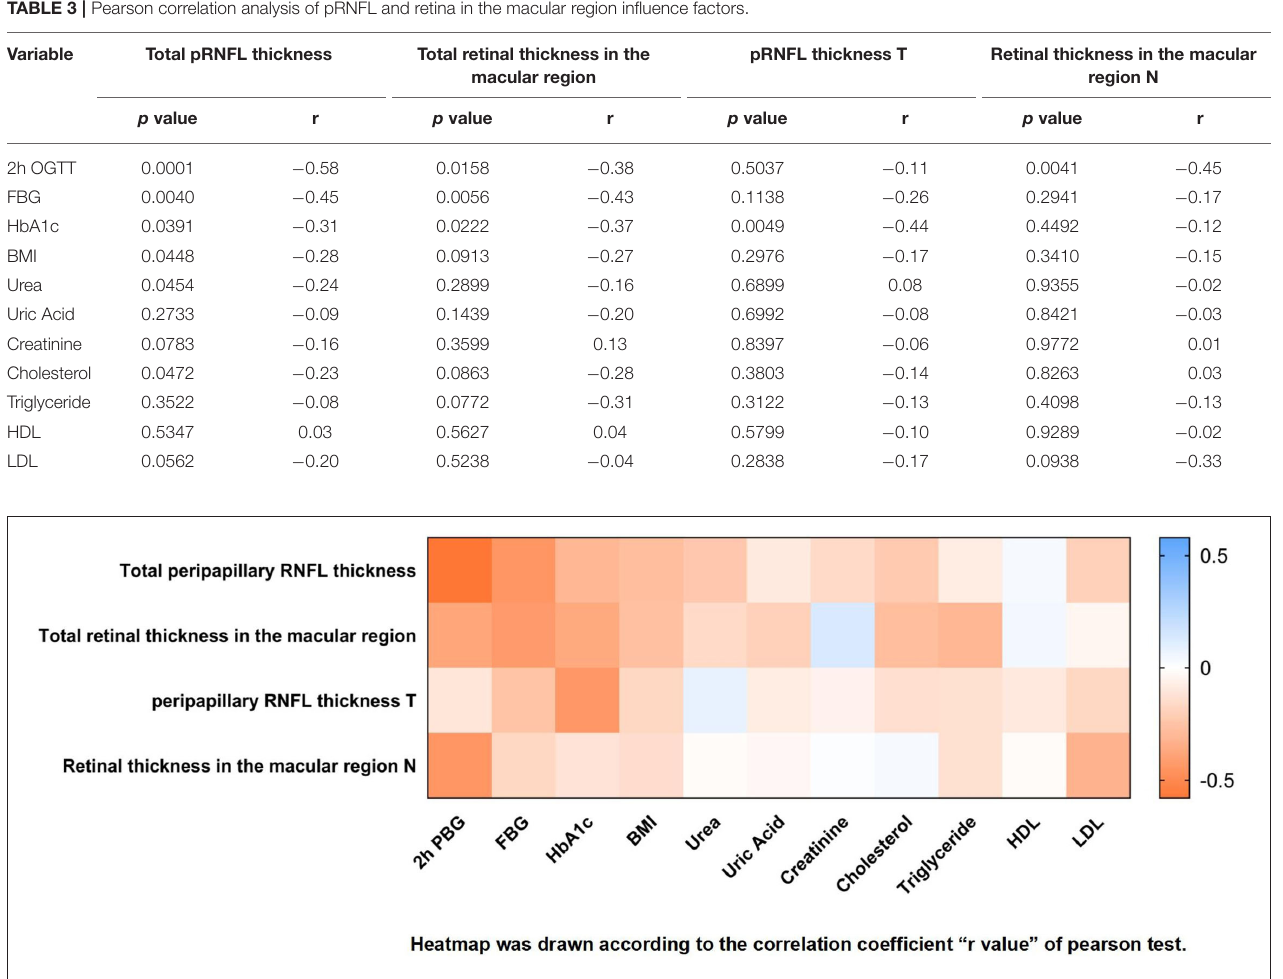
FIGURE 7 | Heat map of correlation analysis of peripapillary RNFL (pRNFL) and retina in the macular region between control group and prediabetes group.